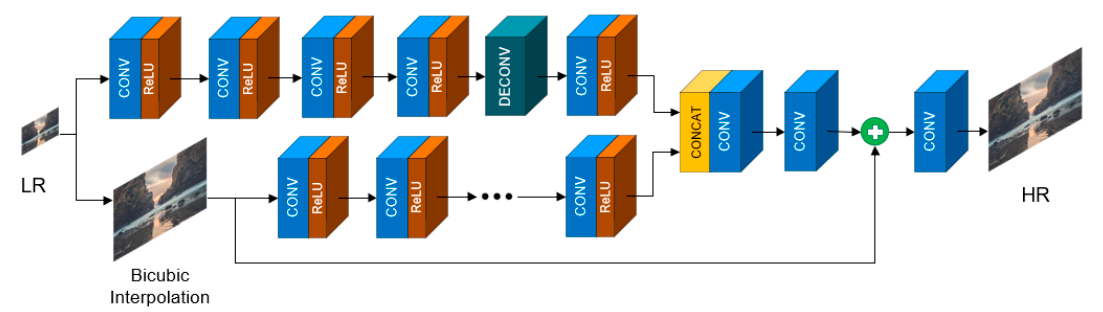
Figure 20. SICNN network structure.